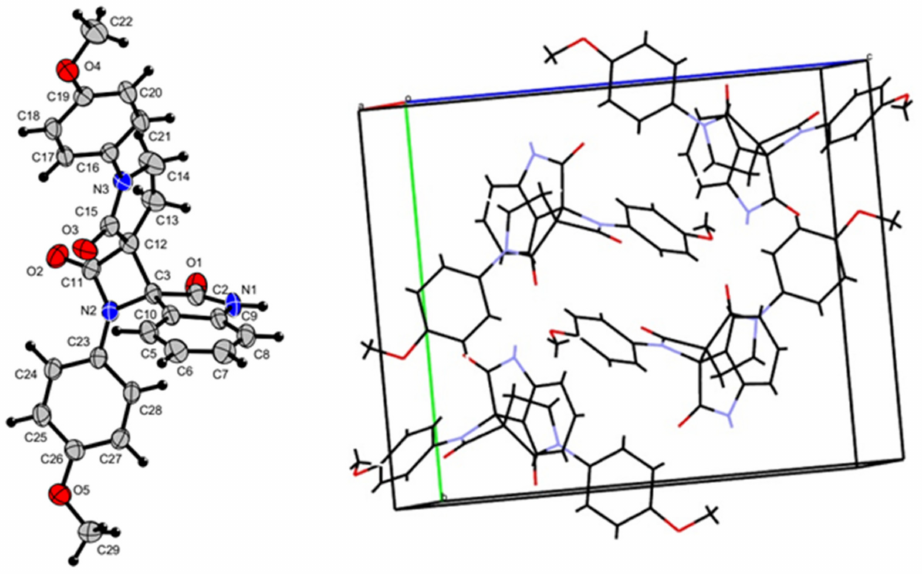
Figure 3. Molecular structure and unit cell of compound 5a .